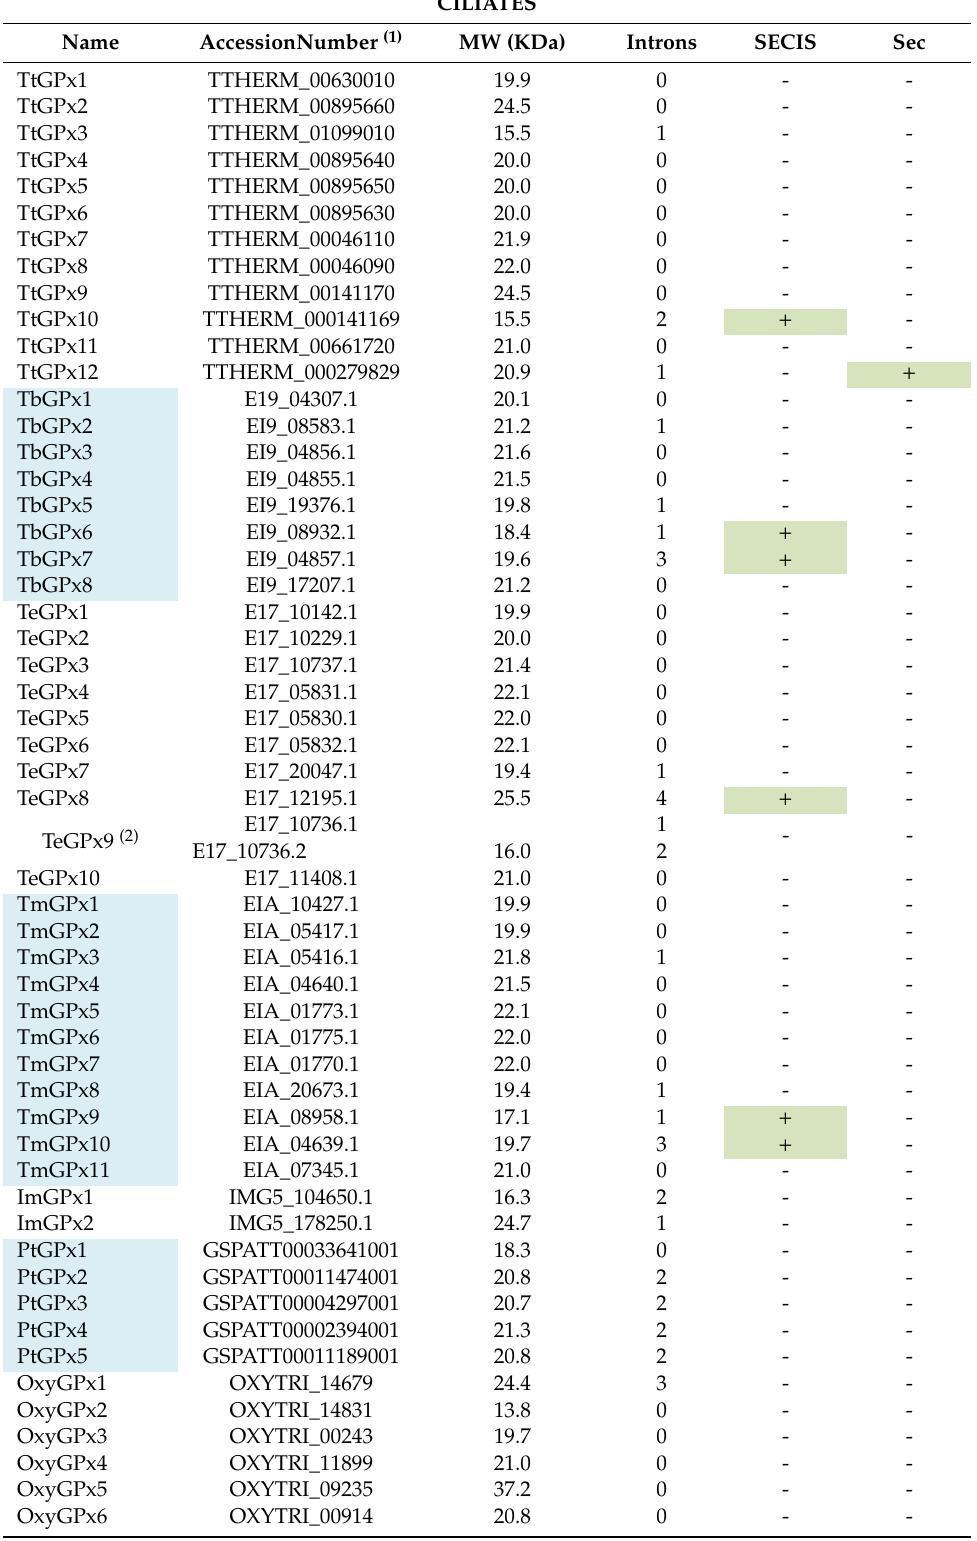
Table 1. Putative glutathione peroxidases (GPx) from Di ff erent Tetrahymena Species, Other Ciliates and Some Other Selected